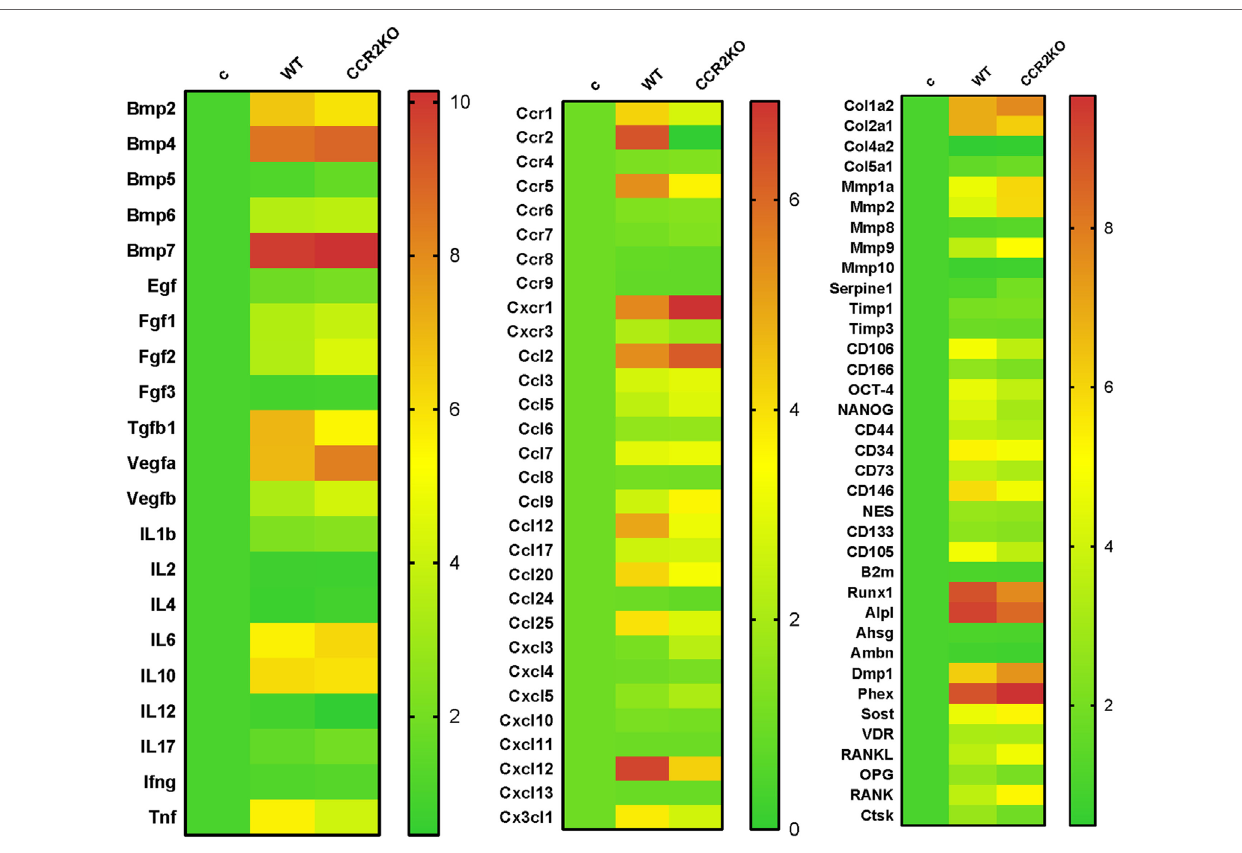
FigUre 5 | Gene expression patterns in the intramembranous bone healing after tooth extraction in wild-type (WT) vs CCR2KO mice. Molecular analysis of the gene expression patterns in the bone healing was performed with a pool of samples from all the experimental time periods (0, 7, 14, and 21 days) for growth factors, cytokines, chemokines, and chemokine receptors, ECM/repair markers, mesenchymal stem cells, and bone markers. Gene expression was performed by using exploratory analysis by RealTime PCR array, with the VIA7 system (Applied Biosystems, Warrington, UK) and a customized qPCR array comprised of the major targets (Osteogenesis, Inflammatory Cytokines & Receptors, and Wound Healing panels) of the PCR array RT 2 Profiler (SABiosciences/QIAGEN). RealTime PCR array analysis was performed with the VIA7 system (Applied Biosystems, Warrington, UK) using a customized qPCR array comprised of the major targets from the Osteogenesis, Inflammatory Cytokines & Receptors, and Wound Healing panels of the PCR array RT 2 Profiler (SABiosciences/QIAGEN). Results are depicted as the fold increase change (and the SD) in mRNA expression from triplicate measurements in relation to the control samples and normalized by internal housekeeping genes (GAPDH, HPRT, and β